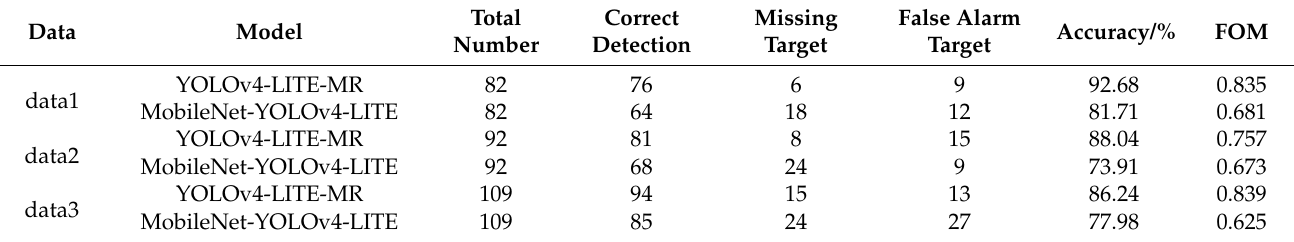
Figure 14. Comparison of the detection results of YOLOv4-LITE-MR (left column) and MobileNet- YOLOv4-LITE (right column) in data3. A and B are sub-images in data3. Table 8. Comparison of detection accuracy of whole SAR